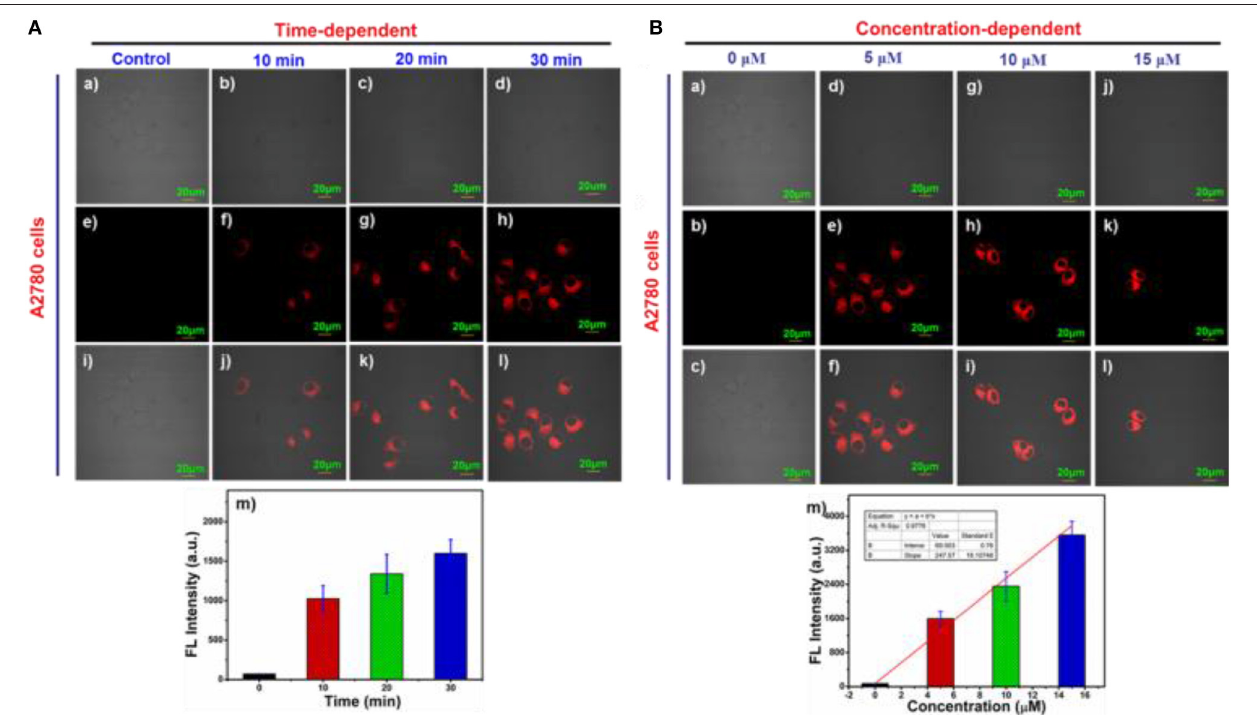
FIGURE 4 | (A) Time and (B) Concentration-dependent imaging of probe NIR-SN-GGT in A2780 cells. (a–d) bright imaging; (e–h) fluorescence imaging; (i–l) merged imaging; (m) fluorescence emission intensities of NIR channel were measured as averages of 9 regions of interest (ROIs) from different treated A2780 cells. Error bar = RSD ( n = 9). λ ex = 488nm and λ em = 655–755nm. Scale bar = 20 µ m.